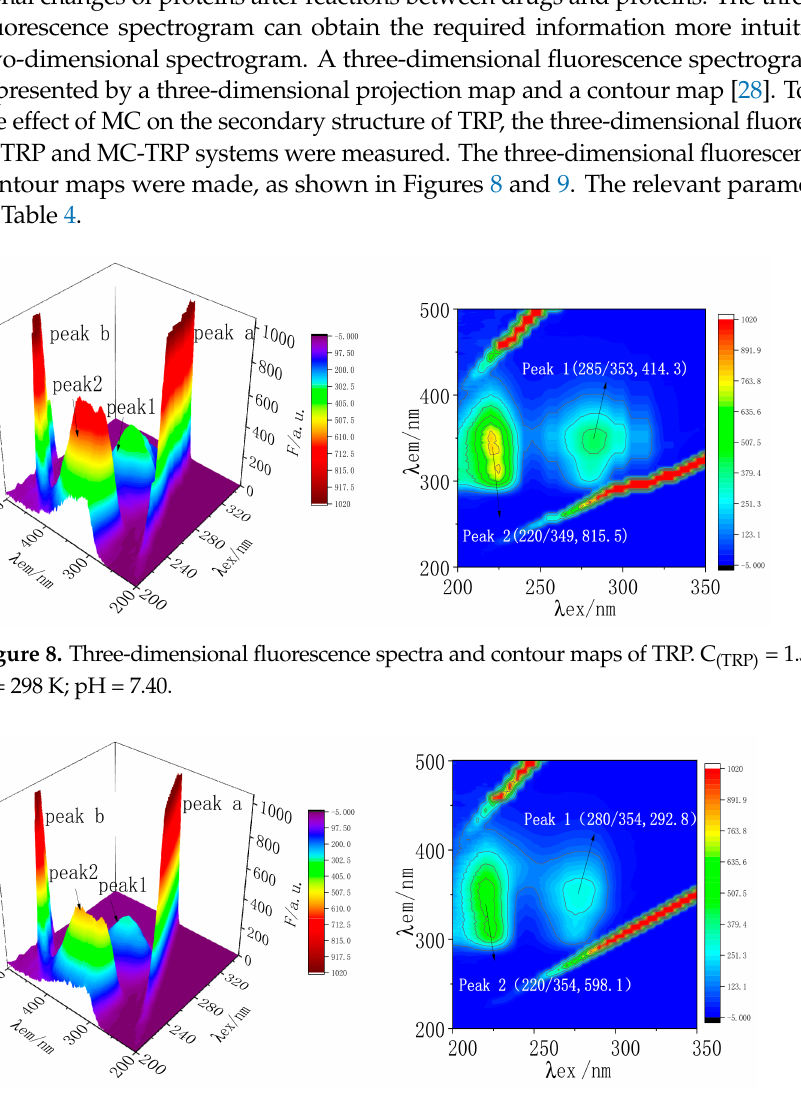
Figure 9. Three-dimensional fluorescence spectra and contour maps of MC-TRP. C (TRP) = 1.5 × 10 − 7 mol/L;